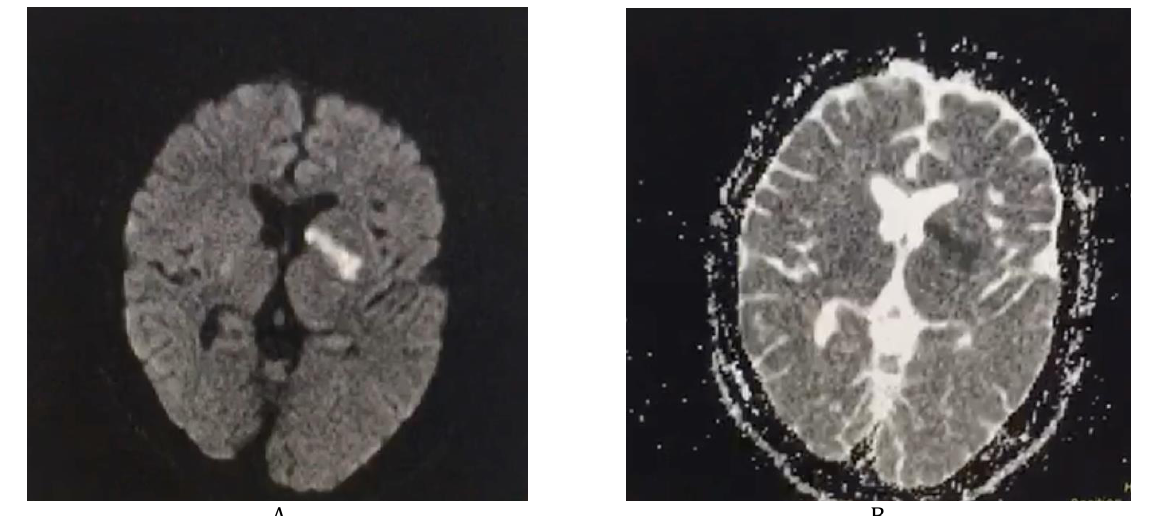
Figure 1. A: Diffusion weighted imaging showed hyperintensity in the head of caudate and the left basal ganglia, B: Apparent diffusion coefficient showed a small hyposignal change in the head of caudate and the left basal ganglia